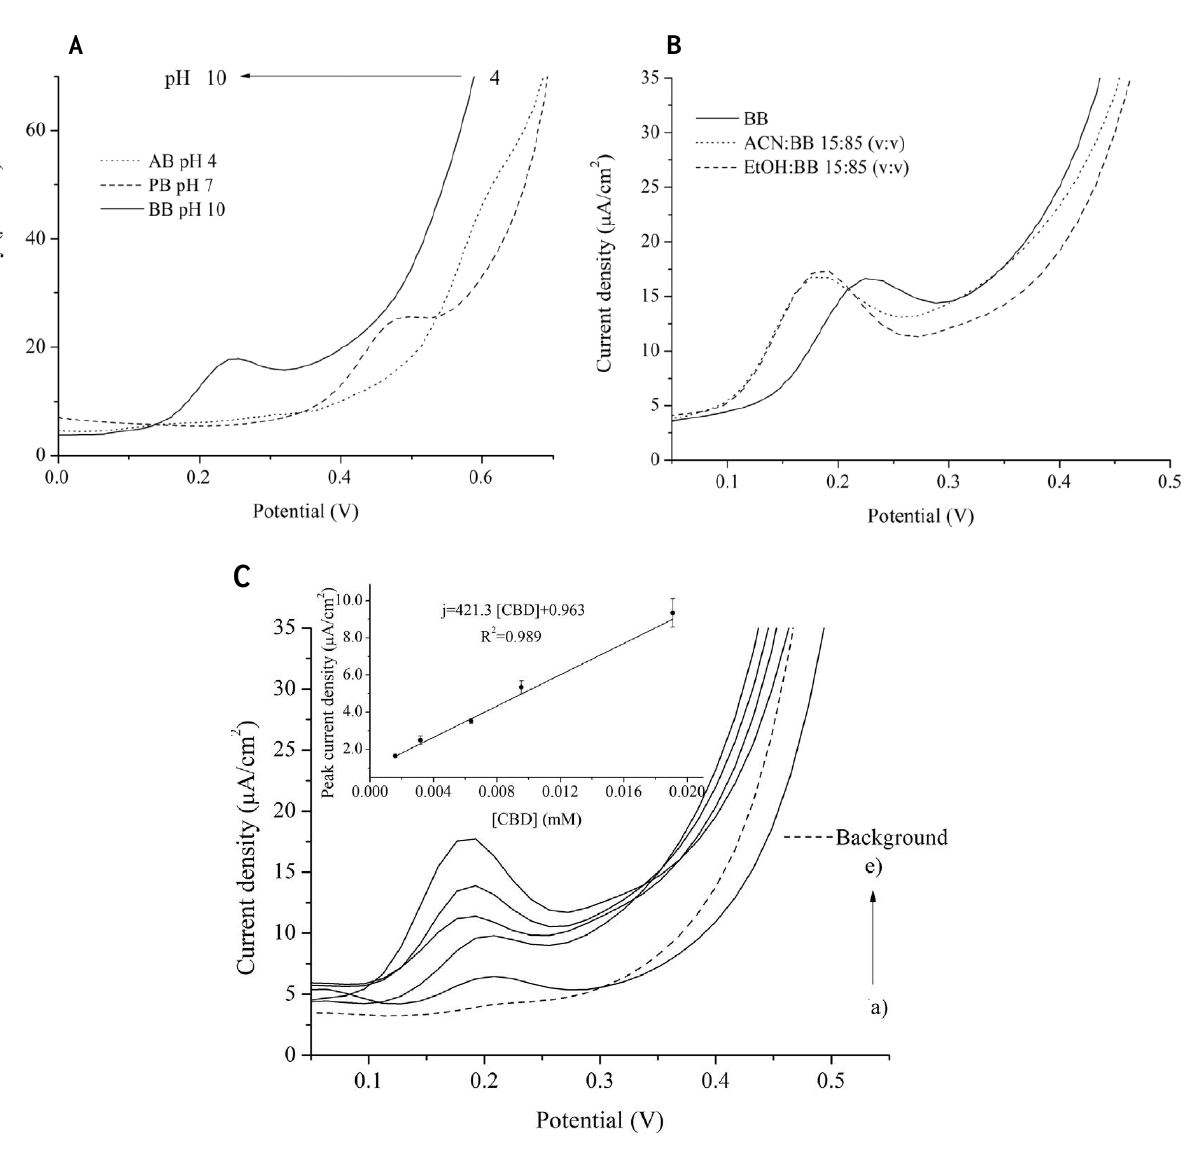
Figure 2. ( A ): DPV signals of Sonogel-Carbon-PEDOT electrodes for 19.1 µ M CBD at different pH: acetic or acetate buffer (AB) with pH 4.0, phosphate buffer (PB) with pH 7.0, and boric or borate buffer (BB) with pH 10.0. ( B ): A comparison between DPV signals of Sonogel-Carbon-PEDOT electrodes for 19.1 µ M CBD in BB, acetonitrile (ACN):BB (15:85), and ethanol (EtOH):BB (15:85). ( C ): Calibration curve and DPV signals of Sonogel-Carbon-PEDOT electrodes at different CBD concentrations. Reprinted and adapted with permission from ref. [8]. Copyright 2020 Elsevier.